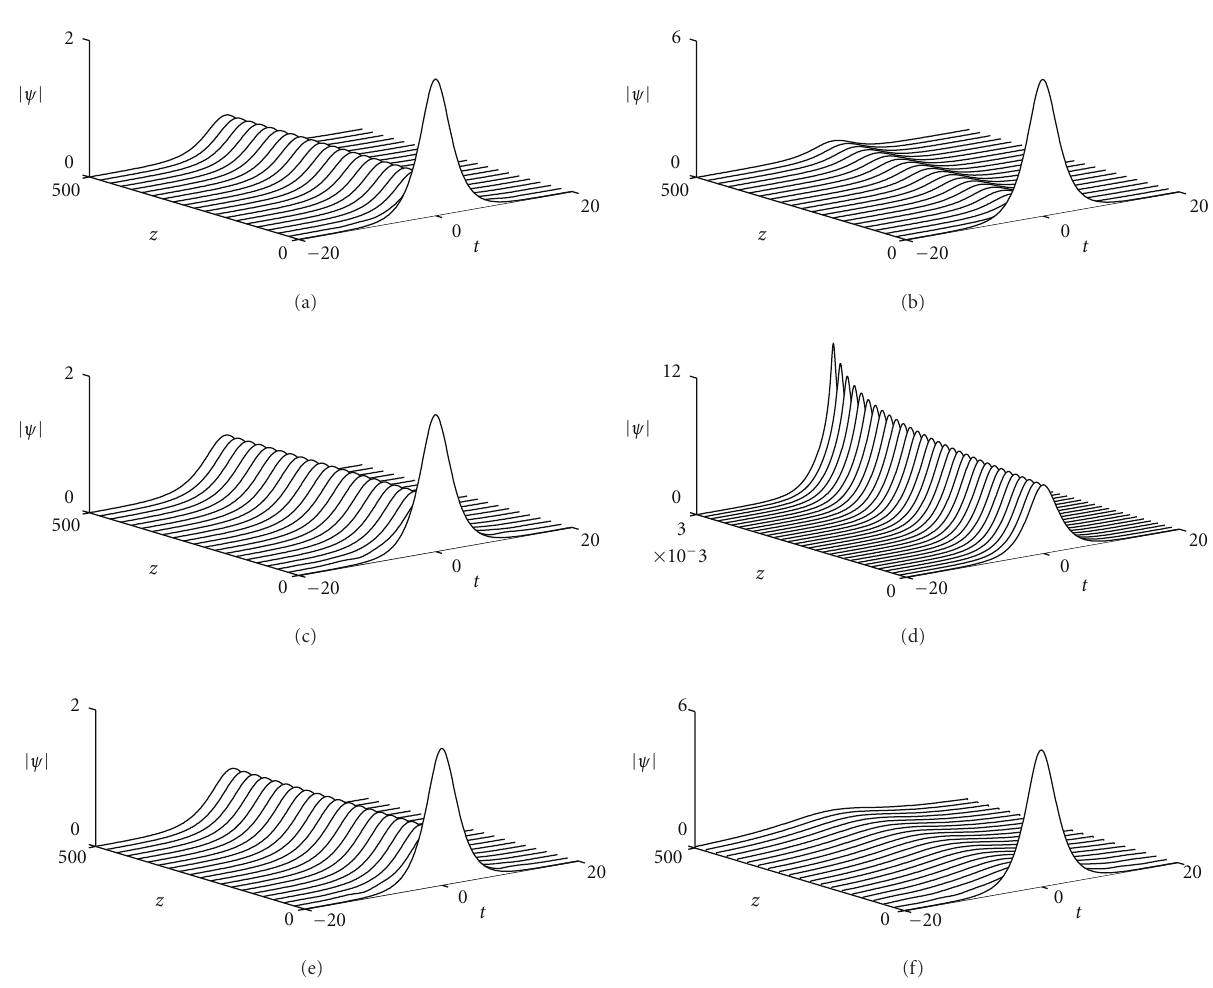
Figure 12: Pulse evolution predicted by the full governing equations ((a) and (b)), CQGLE ((c) and (d)), and SGLE ((e) and (f)). The plots on the left ((b), (d), and (f)) column correspond to the left (b) in Figure 11. The initial conditions for the plots on the left are ψ (0, t ) = 2 sech 0 . 5 t , while those for the right plots are ψ (0, t ) = 6sech 0 . 5 t . The dispersion and pumping strength in all the simulations are D = − 0 . 4 and g 0 = 2 (from [29], 2011,